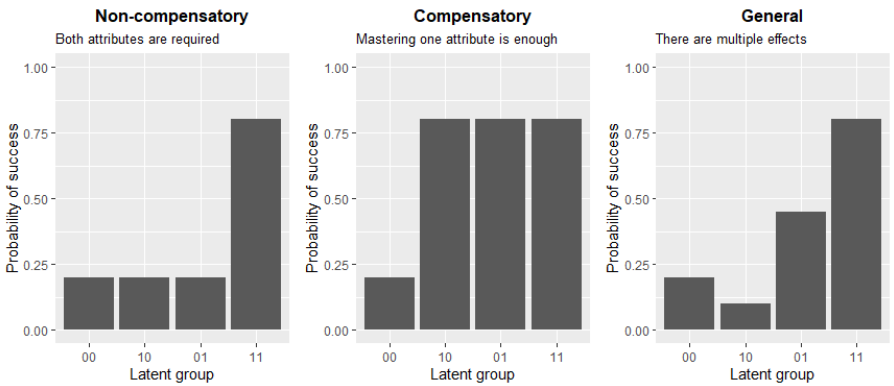
Figure 1. Representation of three items following different response processes.